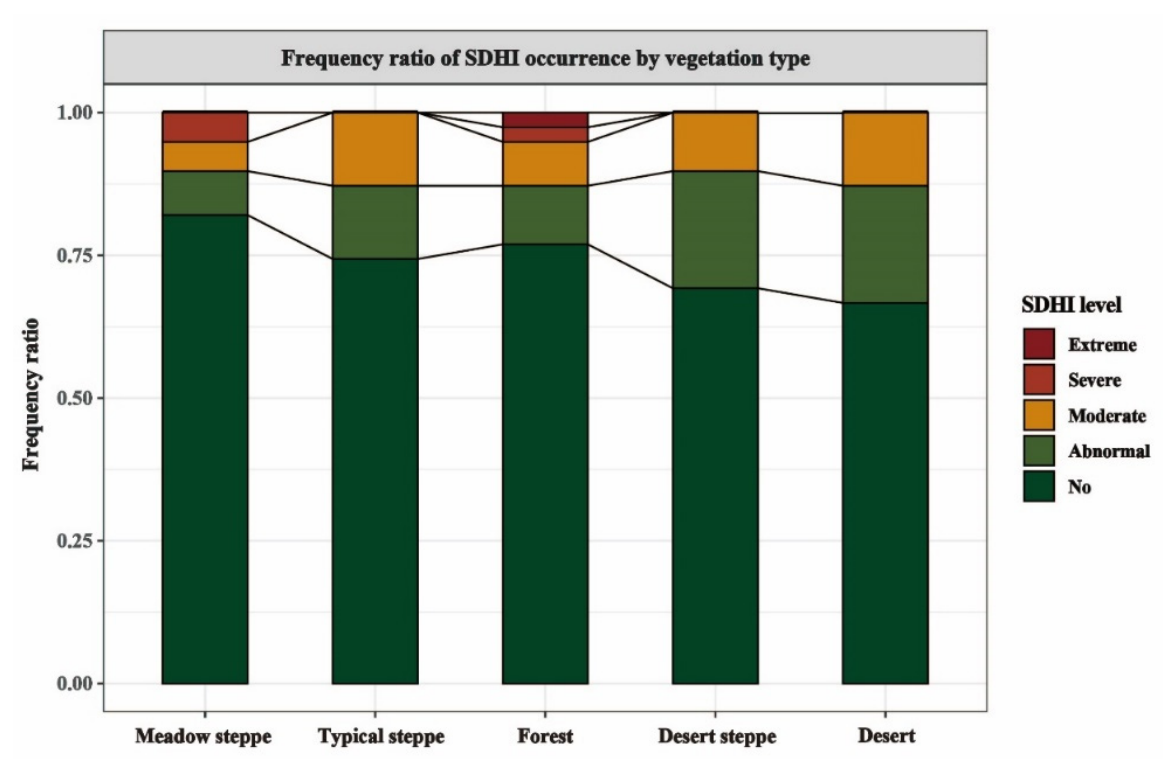
Figure 5. Frequency ratios of SDHI in different grassland types in Inner Mongolia from 1982 to 2020.